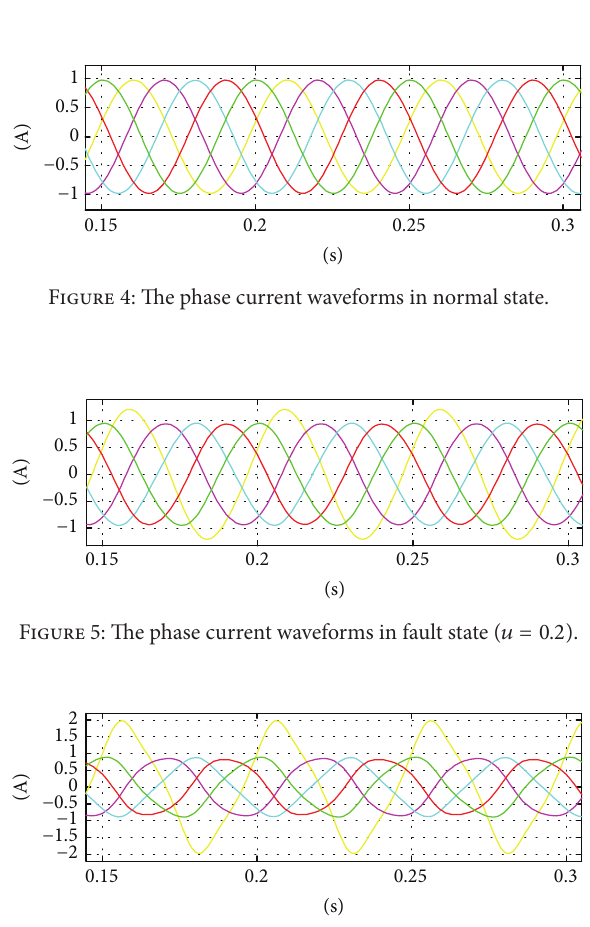
Figure 3: The block diagram of fault parameter identification based on trust region algorithm.